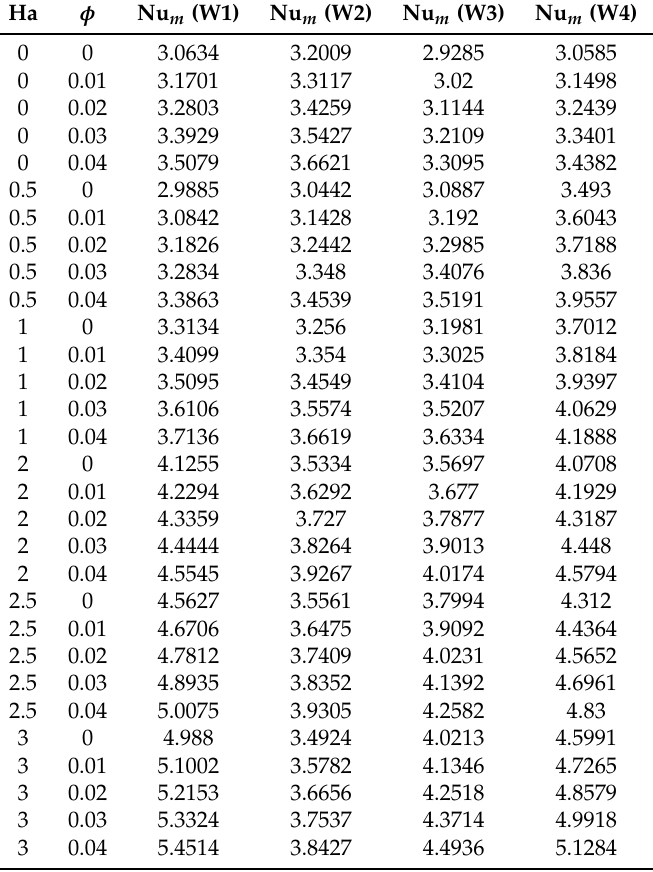
Table 6. Effects of Hartmann number and solid particle volume fraction combination on the variation of average Nusselt number for hot walls of the branching channel (Re =